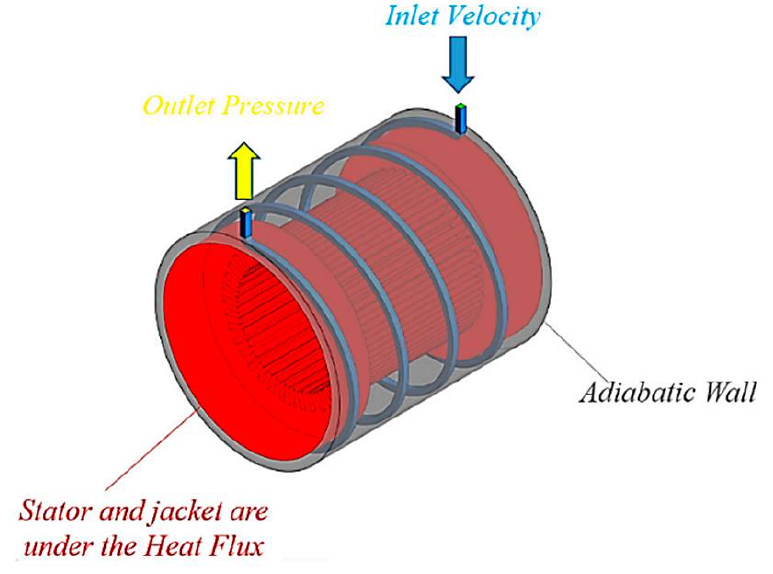
Figure 10. Schematic of the cooling system